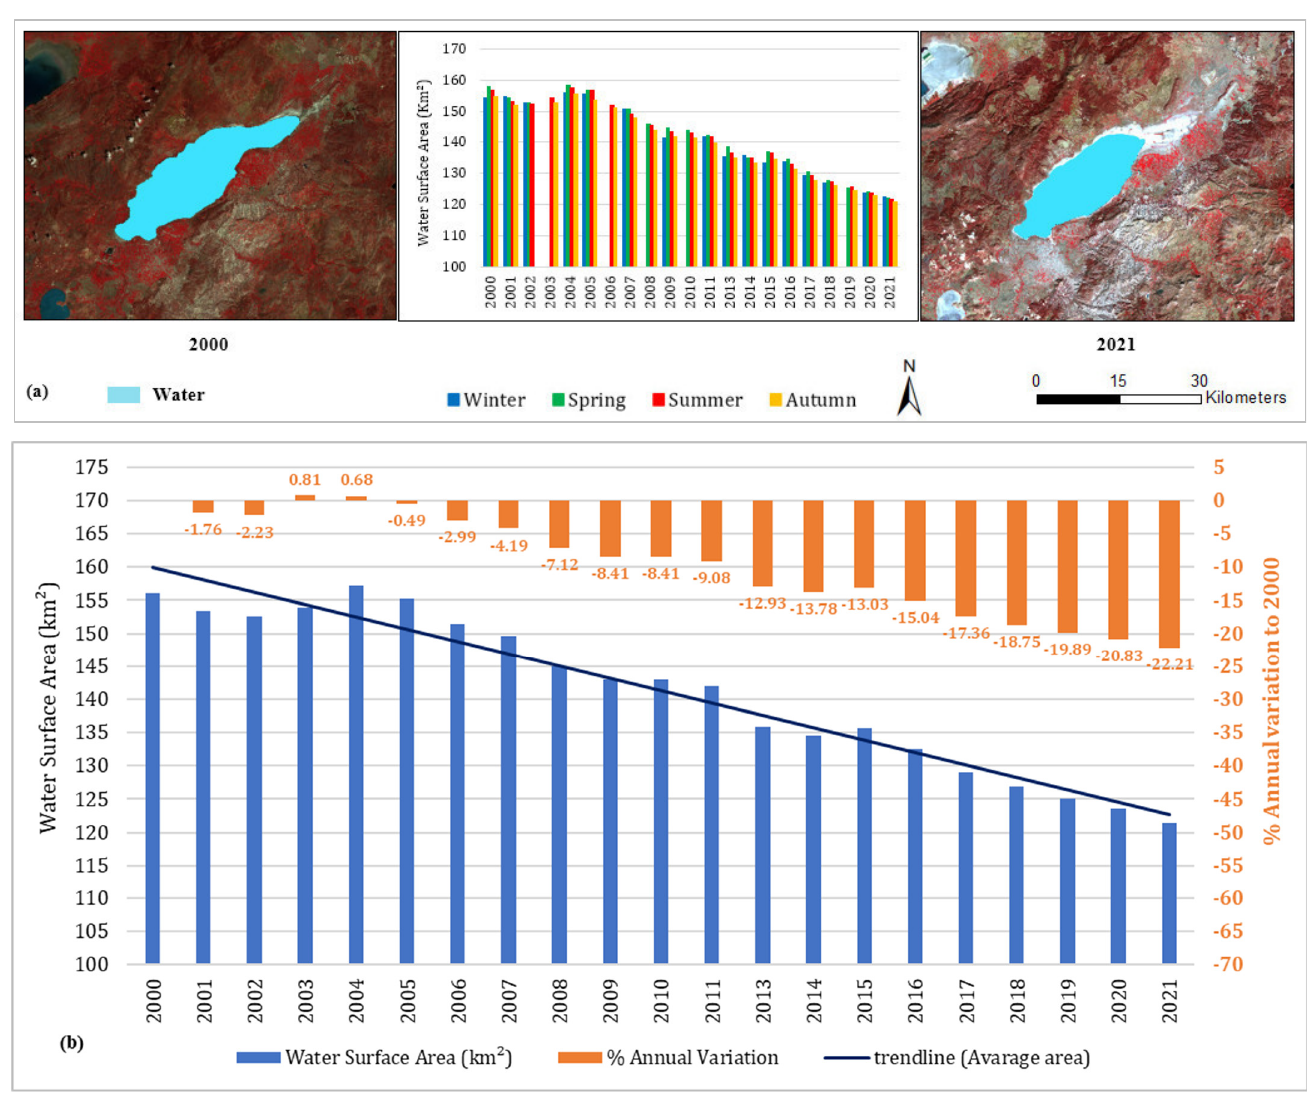
Figure 6. Burdur Lake’s: ( a ) seasonal water surface area changes with RS images for 2000 and 2021; ( b ) long-term annual water surface area variations based on 2000.